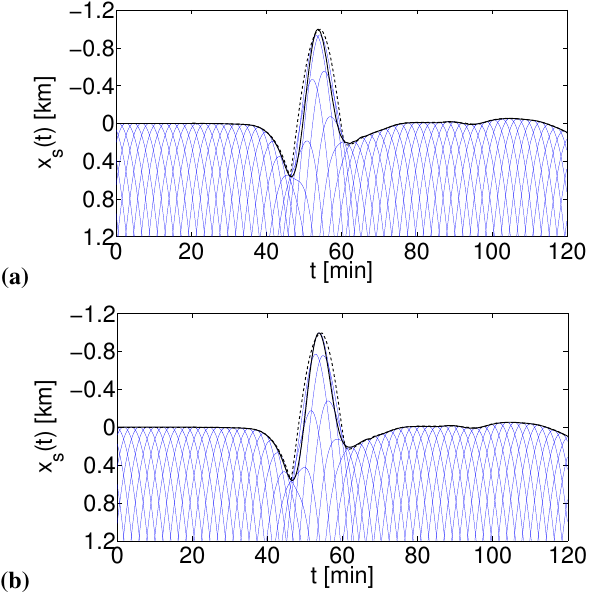
Fig. 17. Shoreline movement in the Aceh case for the linear model Figure 17. Shoreline movement in the Aceh case for the linear ( a : LSWE, b : LVBM) coupled to the NSWE (dashed line) and for model ( a : LSWE; b : LVBM) coupled to the NSWE (dashed line), the linear model with an EBC implementation (solid line). Paths of and for the linear model with an EBC implementation (solid line). Paths of the first-order characteristic curves are shown by thin lines. the first order characteristic curves are shown by thin lines. position is displayed. From this plot, it is shown that the wave runs up 1 km in the horizontal direction in approximately 10 min, roughly in the time interval from 50 to 60 min. For the given slope, it corresponds to a 3 . 3 m run-up height.